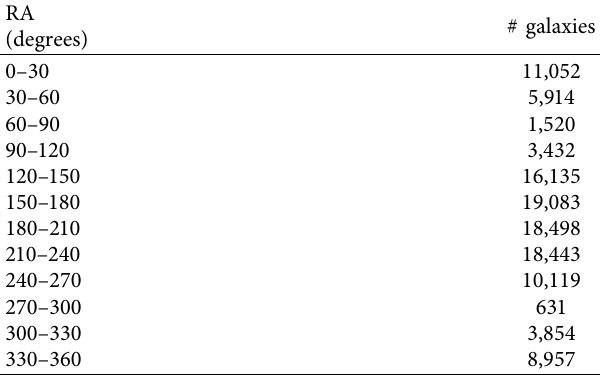
Table 4: The number of SDSS galaxies in different RA 30 o slices. RA